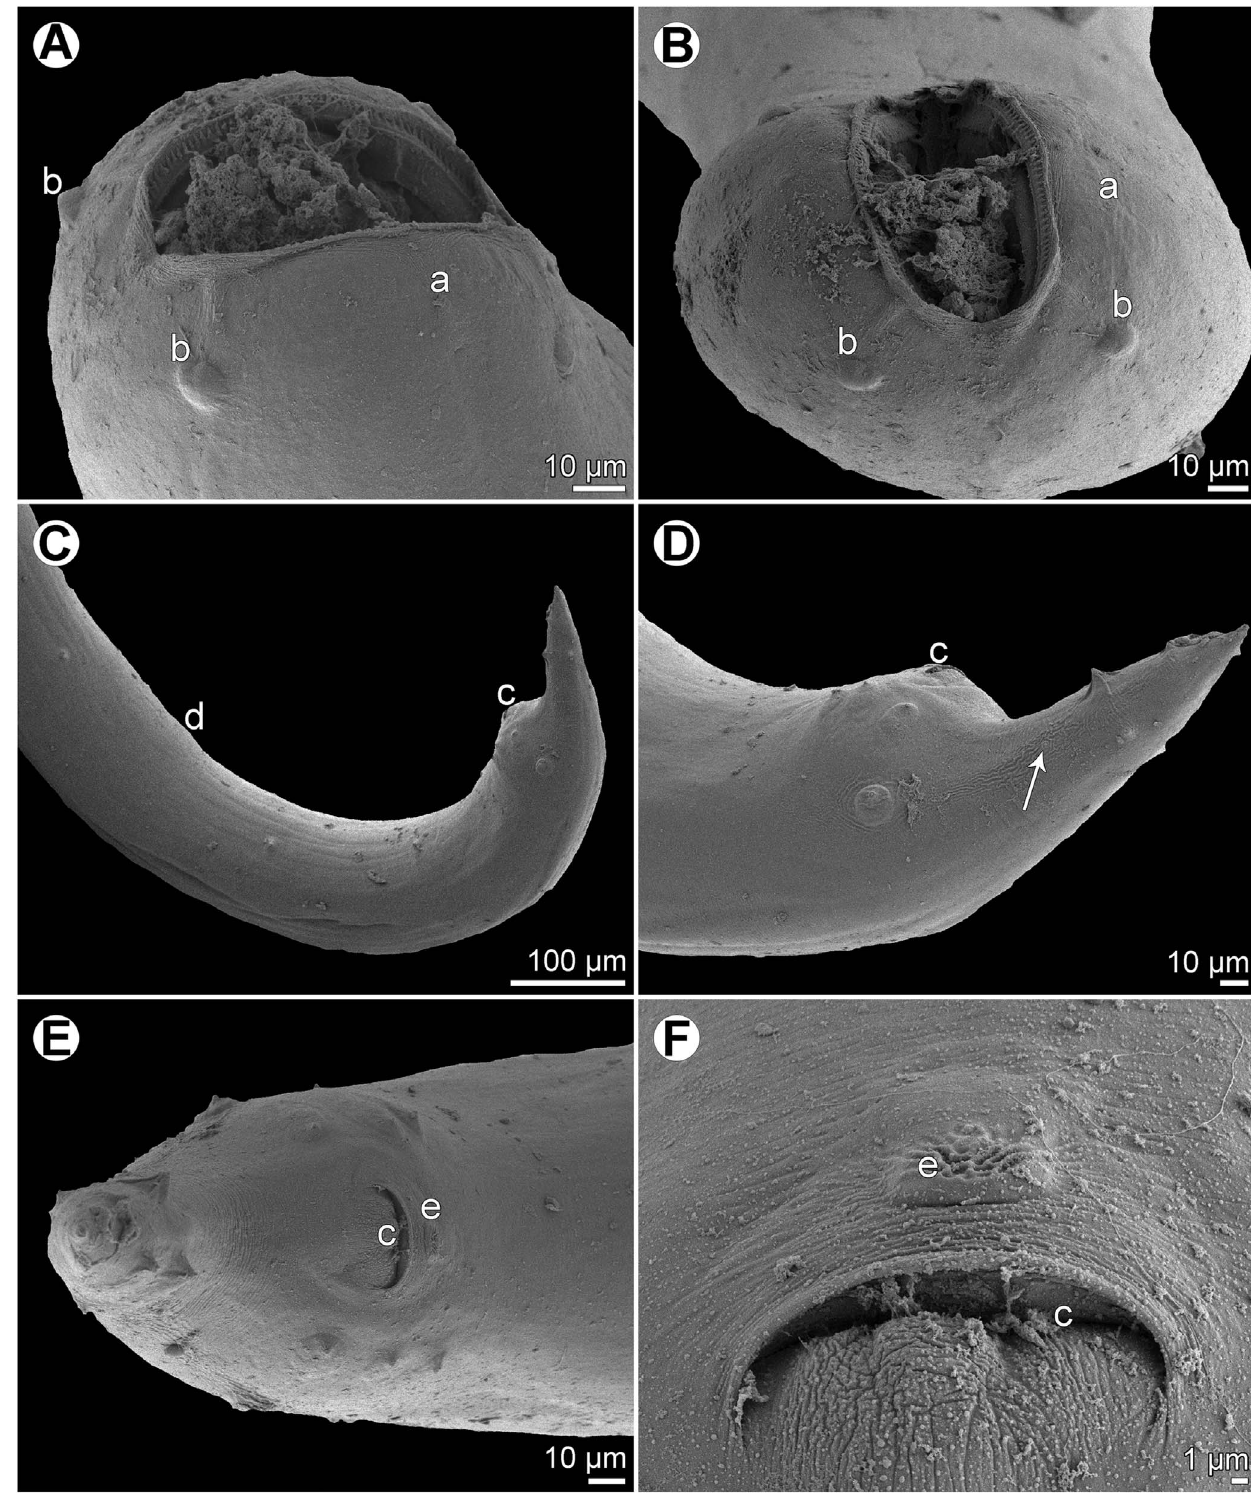
Figure 2. Cucullanus variolae n. sp., scanning electron micrographs of male from V . louti . (A, B) Cephalic end, sublateral and subapical views, respectively; (C) posterior end of body, lateral view; (D) tail, lateral view (arrow indicates phasmid); (E) tail, ventral view; (F) median precloacal elevation, ventral view. (a) Amphid; (b) cephalic papilla; (c) cloaca; (d) ventral sucker; (e) median precloacal